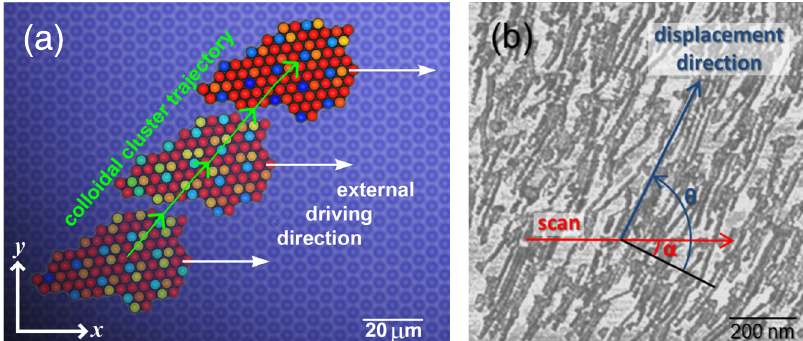
Fig. 7 Directional and orientational locking of clusters driven across periodic surfaces. a Mesoscopic colloidal cluster whose direction of motion (green arrow) substantially deviates from that of the driving force (white arrow) due to the interaction with the underlying periodic substrate potential. In addition to the direction of motion the orientation of the cluster becomes locked during the sliding process. Particles are colored corresponding to their displacement relative to the nearest substrate potential well 142 . b AFM-manipulated crystalline gold nanoparticles on molybdenum disul fi de also displaying a pronounced deviation between the direction of translation (blue arrow) versus external forcing (red arrow) 141 , https://doi.org/10.1103/